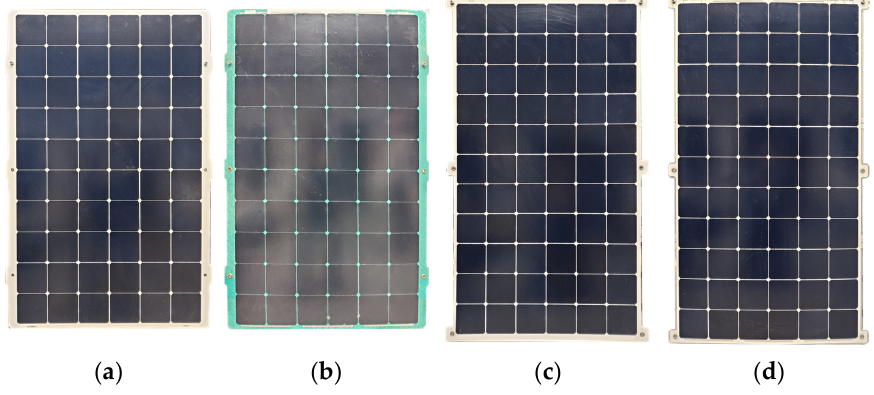
Figure 1. Front overview of prototype modules: ( a ) P1; ( b ) P2; ( c ) P3; ( d ) P4.